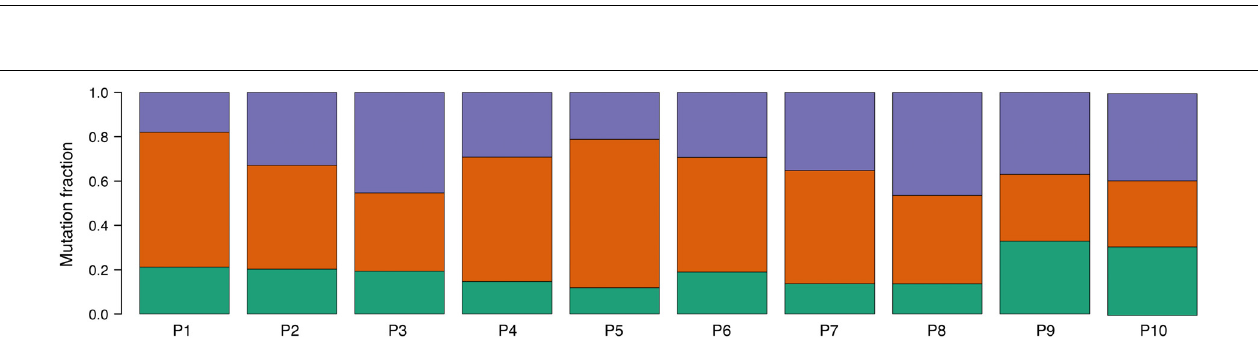
FIGURE 4 | Proportion of COSMIC signatures displaying significant activity in each patient tumor. Color code correspondence is: green, signature 1; red, signature 5; and purple, signature 12.